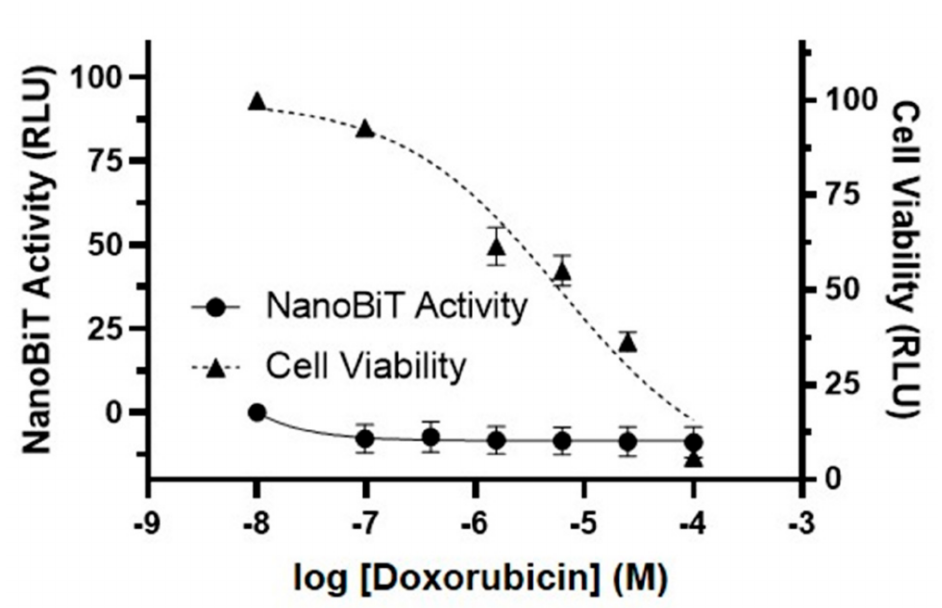
Figure 3. The luciferase complementation assay can easily distinguish 3CL pro inhibition from cytotoxicity. To determine if the luciferase complementation reporter assay can differentiate 3CL pro inhibition from cytotoxicity, 293T cells were transfected with the S-L-GFP lentiviral vector, and DMSO (control) or the anti-cancer drug doxorubicin (0.1–100 µ M) was added. NanoBiT activity (circle, left axis) and cell viability (measured with the CellTiter-Glo 2.0 assay; triangle, right axis) were analyzed 30 h post-transfection and are expressed as relative luciferase units (RLU). Cell viability data were normalized to the DMSO sample, which was set to 100%. NanoBiT data were normalized to the DMSO and 100 µ M GC376 samples, which were set to 0 and 100%, respectively. The data represent the mean ± standard deviation of three independent